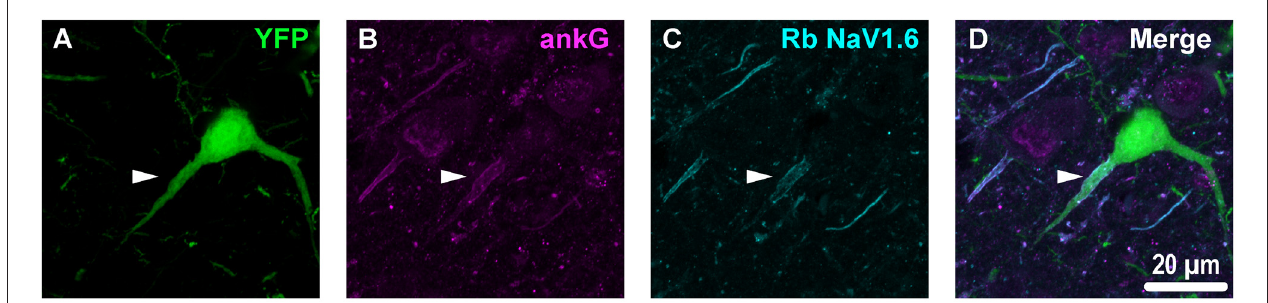
FIGURE 4 | YFP+ pyramidal neuron axonal injury attenuates ankG and NaV1.6 expression at the AIS. (A–C) Representative images of YFP (A) ankG (B) and NaV1.6 (C) . (A) Evidence of DAI occurring at the AIS of a YFP+ pyramidal neuron (green) is indicated by a severely swollen proximal segment (arrowhead). (B,C) AnkG (magenta) and NaV1.6 (cyan) expression persists, but is substantially attenuated with abnormal morphology after mTBI-induced AIS injury. (D) Composite image showing ankG and NaV1.6 within the swollen AIS of a YFP+ pyramidal neuron.